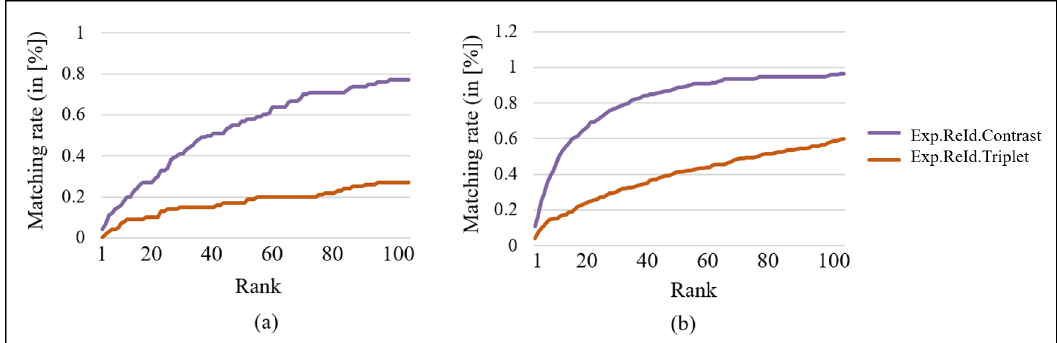
Figure 10. CMC curves of Appearance Affinity model trained with the Double-Margin-Contrastive loss and the Triplet loss over ( a ) PRID2011 and ( b )VIPeR dataset.